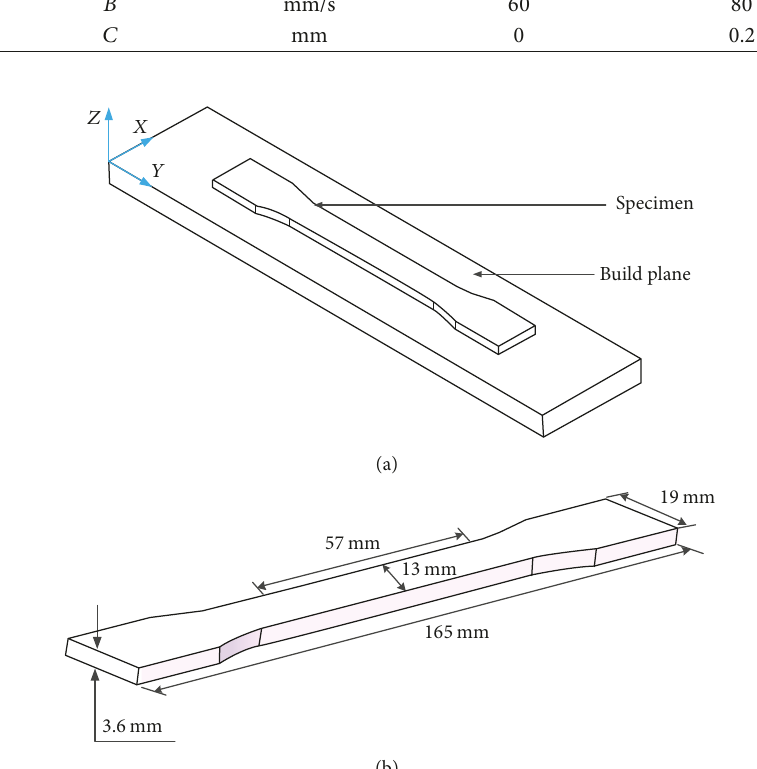
Figure 1: (a) Build orientation used for the fabrication of ASTM D638; (b) ASTM D638 type I specimen design and dimensions.